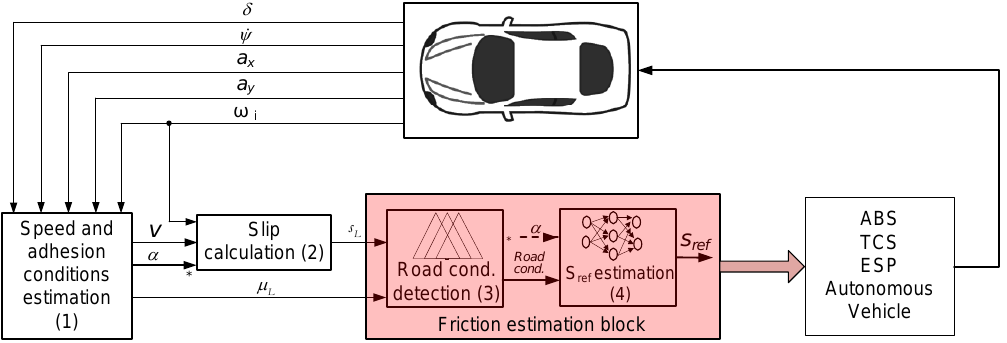
Figure 3. Block diagram of the friction estimation algorithm.